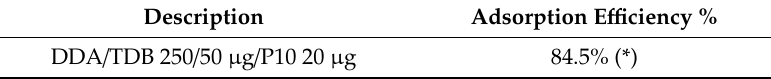
Table 2. Adsorption efficiency of peptide P10 onto liposome of DDA/TDB .